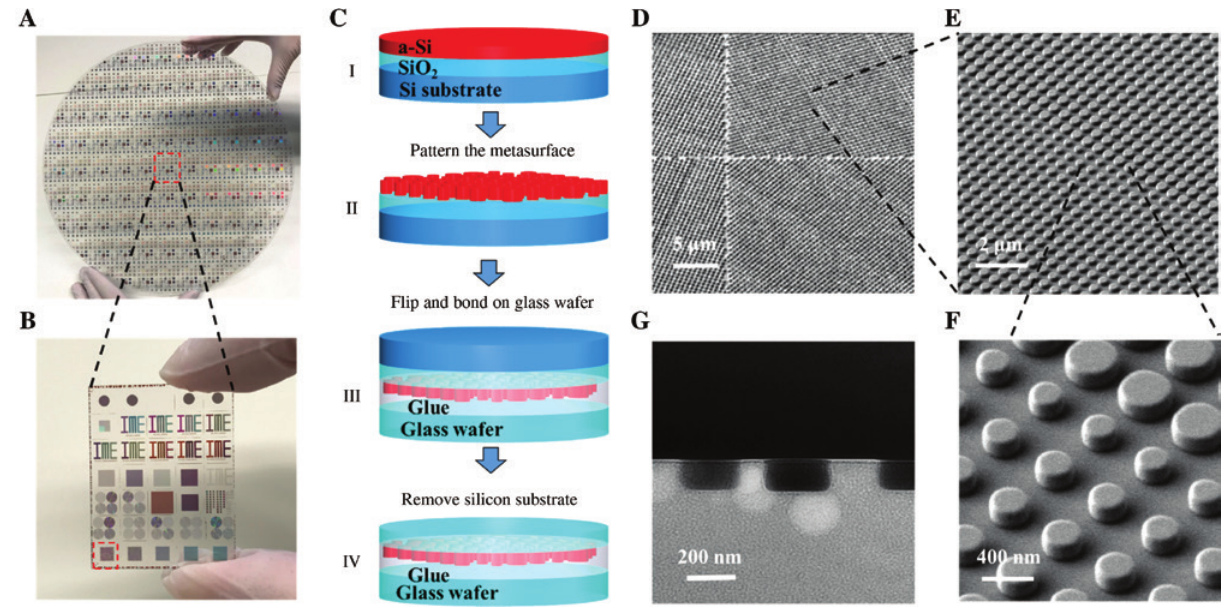
Figure 3: Fabrication of the large-area pixelated metasurface beam deflector on a 12-inch glass wafer. (A) The photo of the fabricated 12-inch glass wafer, with highlighted area denoting central die. (B) Central die with dimension of 33 × 26 mm 2 , with highlighted area indicating the pixelated metasurface beam deflector. (C) Schematic of the fabrication process for layer transfer on glass wafer: (I) 12-inch Si wafer with SiO and a-Si layer deposited both via PECVD; (II) patterning of the photoresist using the 2 193-nm immersion lithography, followed by ICP etching of the metasurface layer; (III) spin coating of the bonding glue, followed by the bonding of Si wafer with glass wafer; and (IV) backside grinding and polishing, followed by wet etching process to remove the Si substrate. (D) The projected scanning electron microscopy of the fabricated metasurface layer after the ICP process, with projection angle of 45 ° . (E) Zoomed-in view of (D) for one pixel of beam deflector. (F) Zoomed-in view of (E) showing the nanopillar fabricated on Si substrate. (G) Cross-sectional transmission electron microscopy image of the nanopillars on glass embedded in bonding